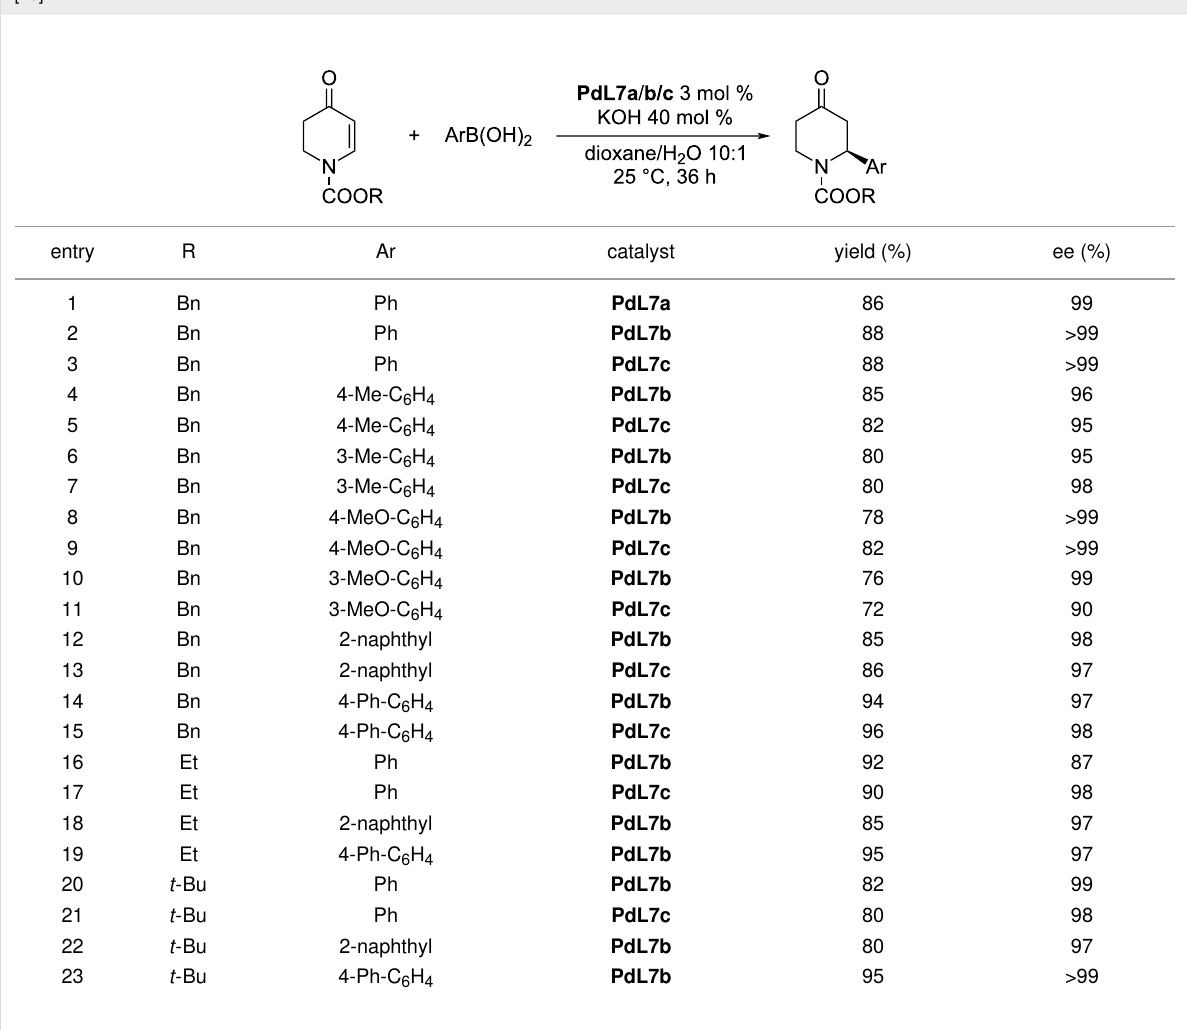
Table 15: Addition reaction of arylboronic acids to various 4-oxo-3,4-dihydropyridine-1(2 H )-carboxylates catalysed by Pd-NHC complexes PdL7a–c